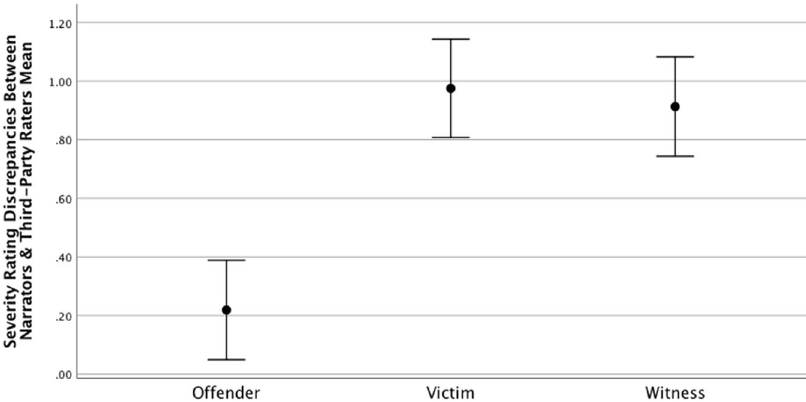
Fig. 6 Severity ratings of recipients minus severity rating of narrators divided into offenders, victims, and witnesses. The fi gure shows the severity ratings for the recipients minus the severity ratings for the narrators divided into divided into offenders, victims and